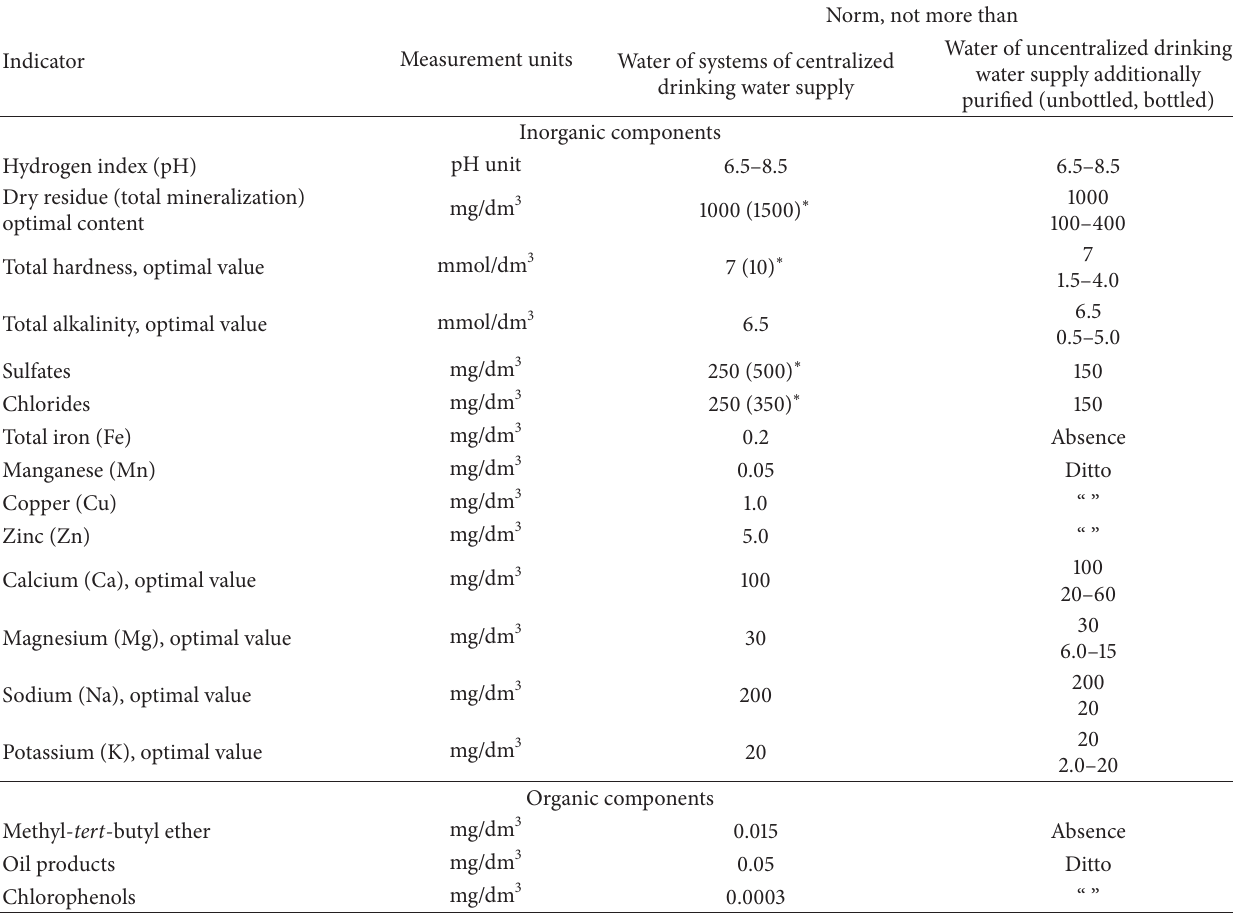
Table 5: Chemical indicators of quality, which affect the organoleptic properties of drinking